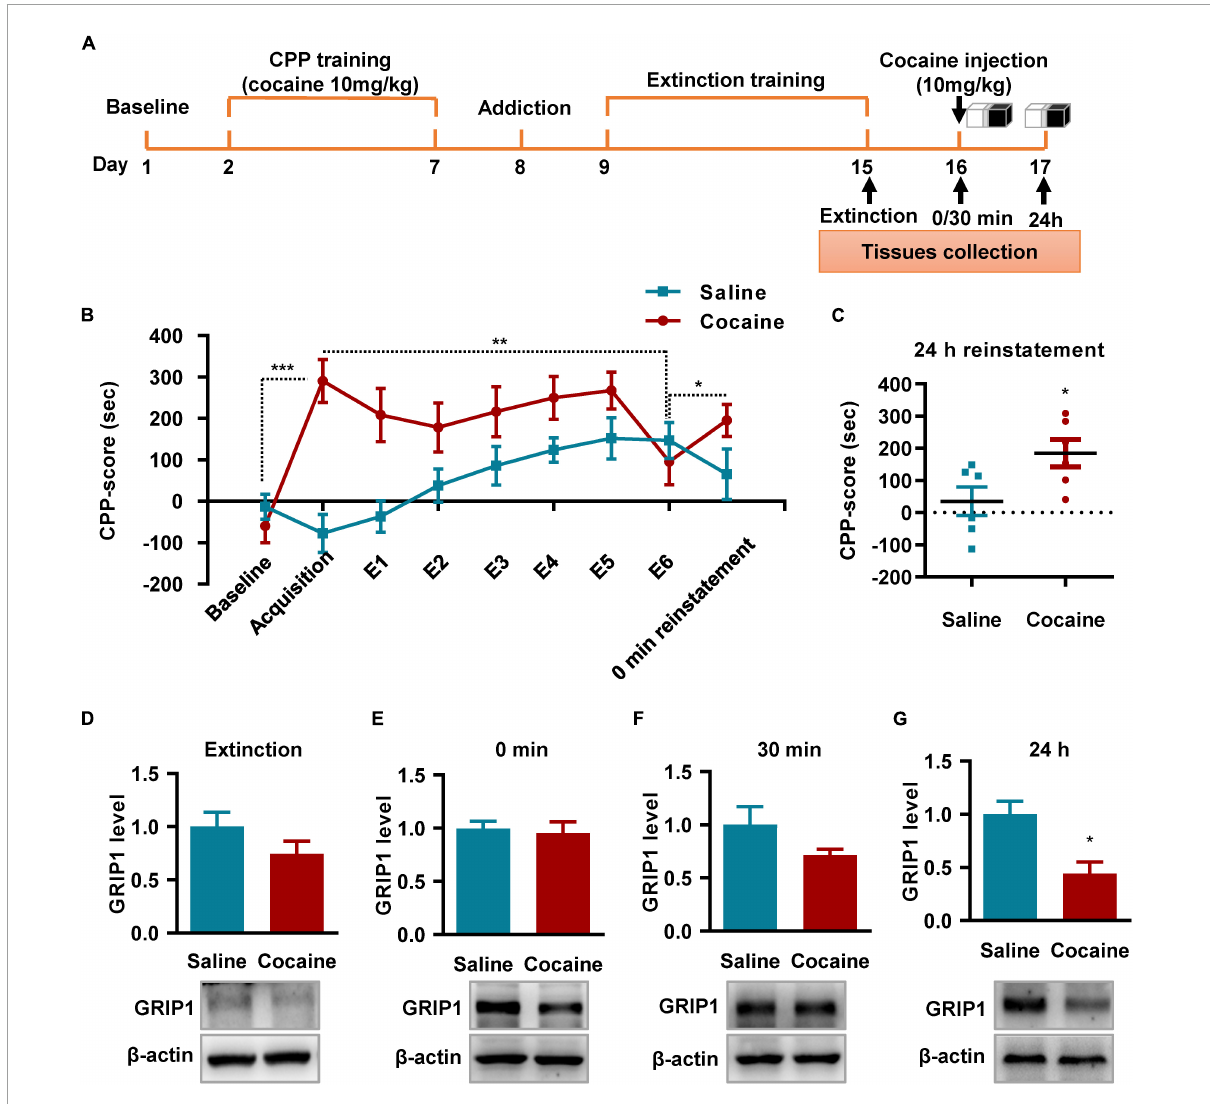
FIGURE5 GRIP1 expression decreases at 24 h after cocaine-induced reinstatement. (A) The timeline of cocaine or saline treatment applied for detecting GRIP1 expression in the NAc. Three-compartment biased CPP models were used. (B) The CPP score during the test schedule. n = 10 mice per group. (C) The CPP score at 24 h after cocaine-induced reinstatement. Student’s t -test, n = 6 mice per group. (D–G) The expression of GRIP1 in the NAc decreased at 24 h after cocaine-induced reinstatement compared to the saline control group (C,E) , but there were no significant changes after extinction (D) or at 0 min (E) or 30 min (F) after cocaine-induced reinstatement compared to the saline control. The saline treatment group was set as 1 for quantification. Student’s t -test, n = 4 mice per group. * P < 0.05, ** P < 0.01, and *** P <